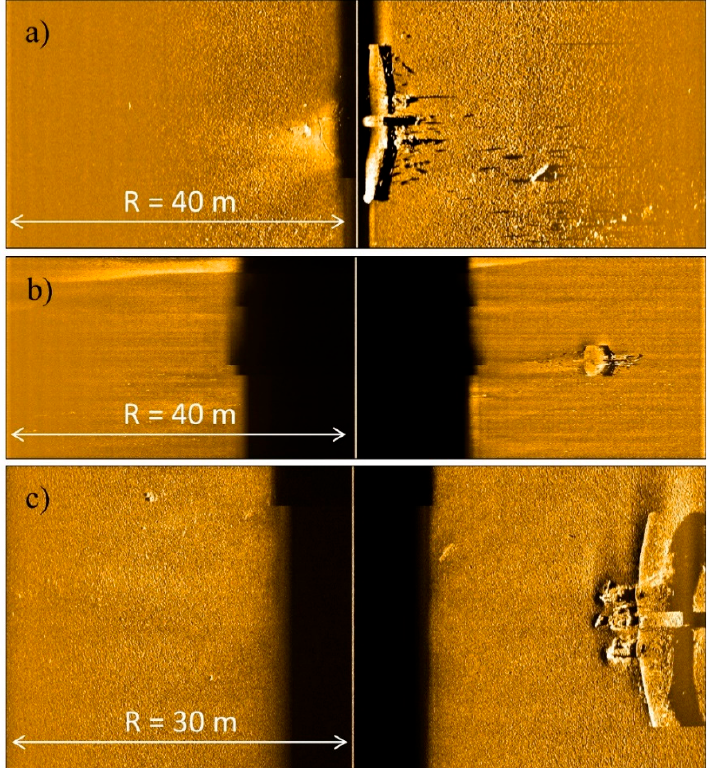
Figure 7. Side scan sonar data of little utility and value: ( a ) sonar is flying too low and too close to the wreckage; ( b ) sonar is flying too high above the bottom; ( c ) sonar is flying too far from the wreckage.